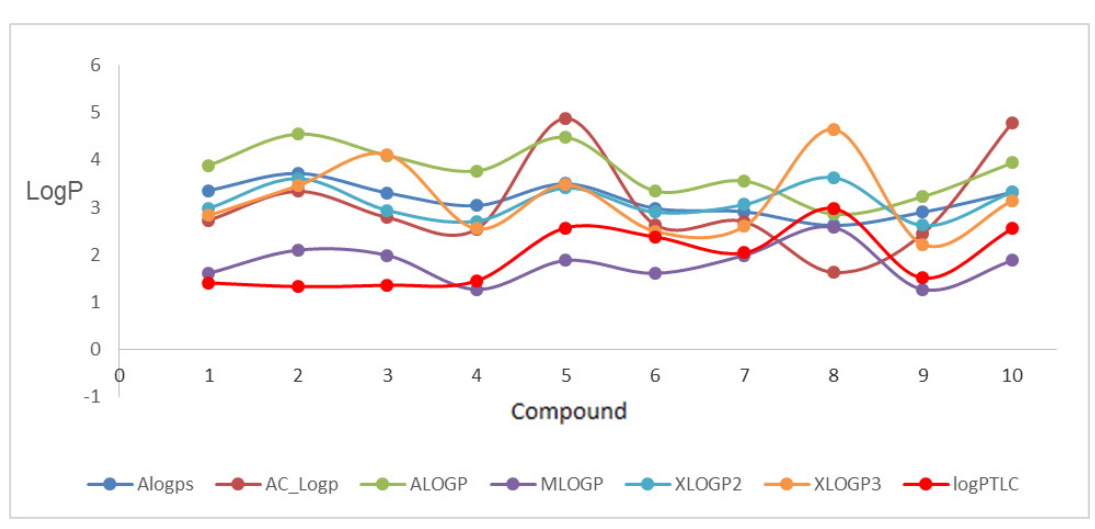
Figure 3. Graphical visualization of calculated log P values (using VCCLAB models) of the tested compounds with a comparison to log P TLC .